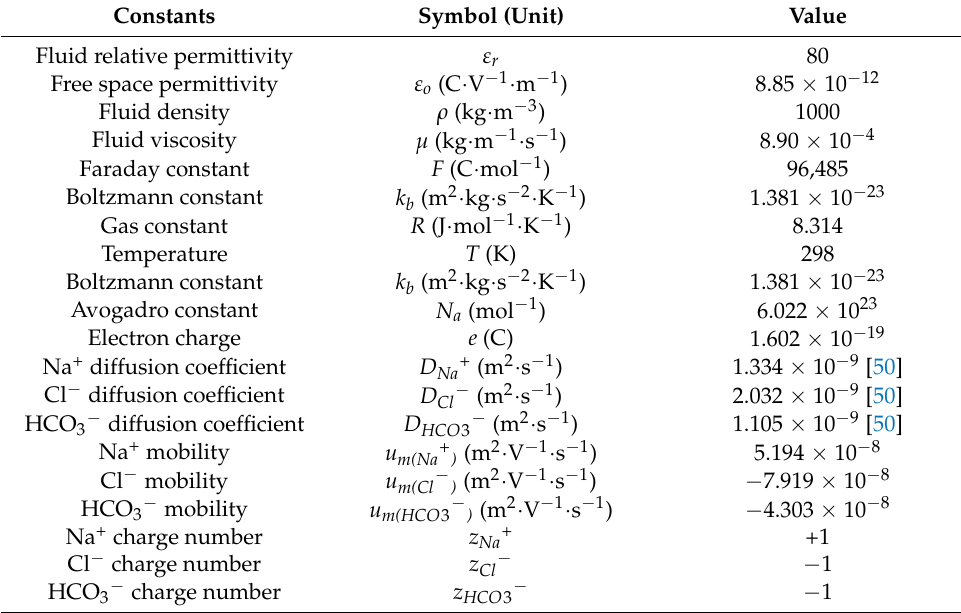
Table 4. Symbols and values of constants for simulations, with ion mobility determined by ( z i D i F )/( RT